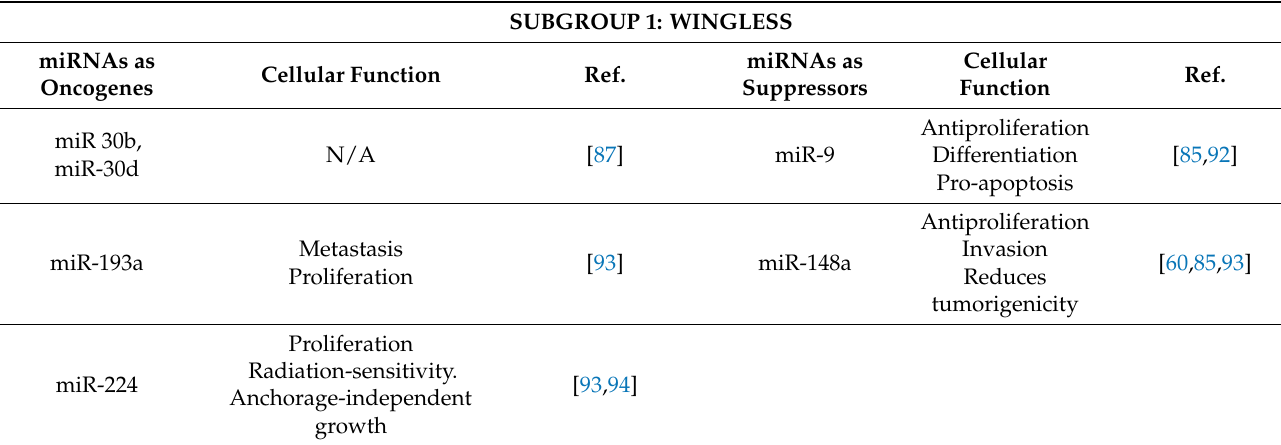
Table 1. Summary of deregulated miRNAs involved in the pathogenesis and progression of the four MB subgroups. SUBGROUP 1: WINGLESS miRNAs